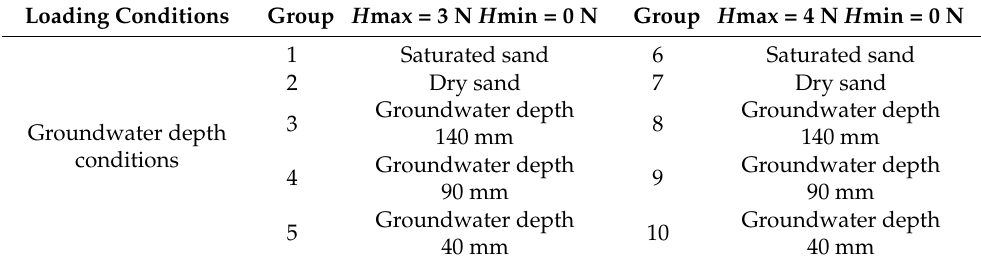
Table 4. Cyclic loading test scheme.